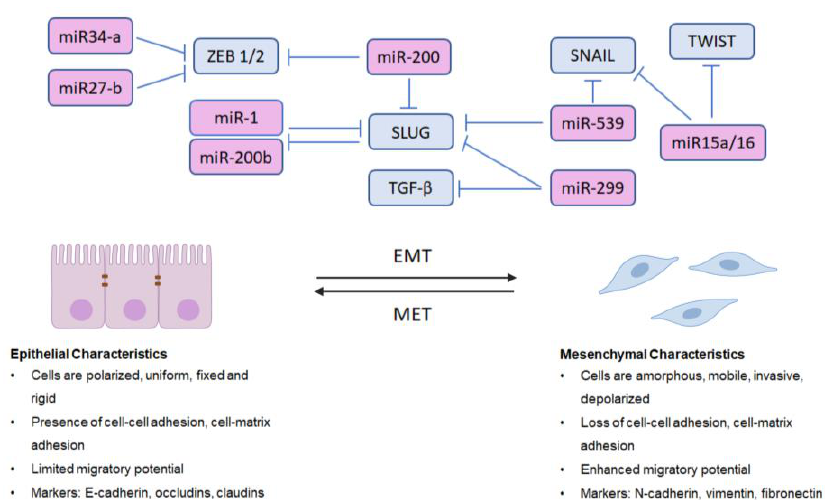
Figure 1. microRNA (miRNA) Regulation of Epithelial-to-Mesenchymal Transition (EMT) in Cancer. Over 30 different miRNAs are now known to interact with EMT-related signaling effectors in prostate cancer. This schema reveals the critical miRNAs that negatively regulate EMT, via inhibition of SNAIL, SLUG, ZEB1/2, TWIST and TGF- β . Regulation of EMT is complex, as miRNAs can have multiple targets (miR-299, miR15a/16) or are themselves regulated by EMT components in a feedback loop (miR-1/miR-200b and SLUG). The process of EMT involves the cellular transformation from an epithelial phenotype to a mesenchymal one in preparation for metastasis. Utilizing miRNAs and other non-coding RNAs (ncRNAs) to regulate EMT interconversion to mesenchymal-to-epithelial transition (MET) in order to impair metastasis could be a novel therapeutic strategy to treat advanced or resistant prostate cancer.